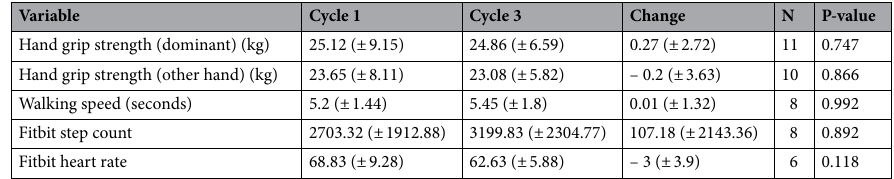
Table 4. Patient performance. N sample size. 6–11 patients are included in analysis due to missing data at Cycle 1 or 3. Data are presented as mean (± standard deviation). P-value is calculated by paired sample t-test.